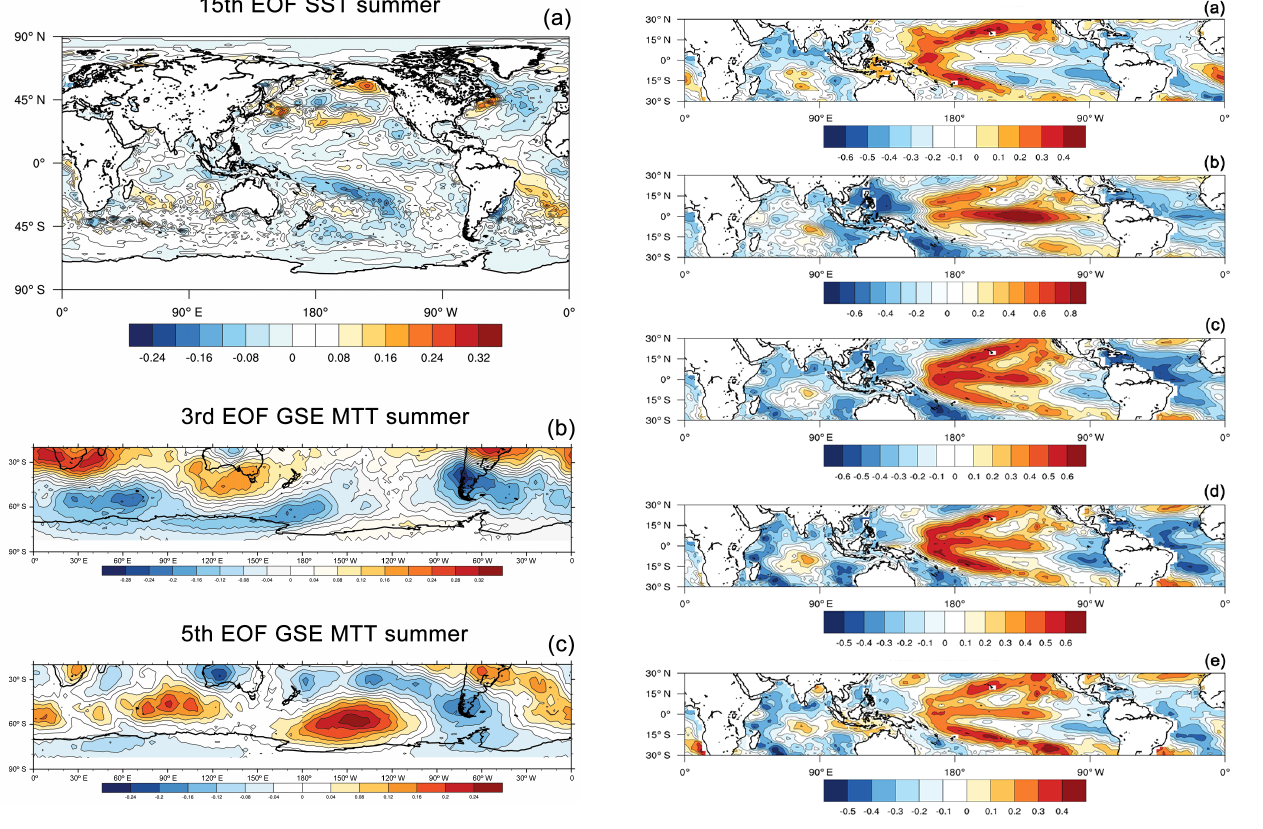
Figure 6. (a) The summer SST field reconstructed from the ob- servations, from (b–e) represent the correlations maps between the summer SST field and the time coefficients of the T-model, NP, SAIA and RB region,